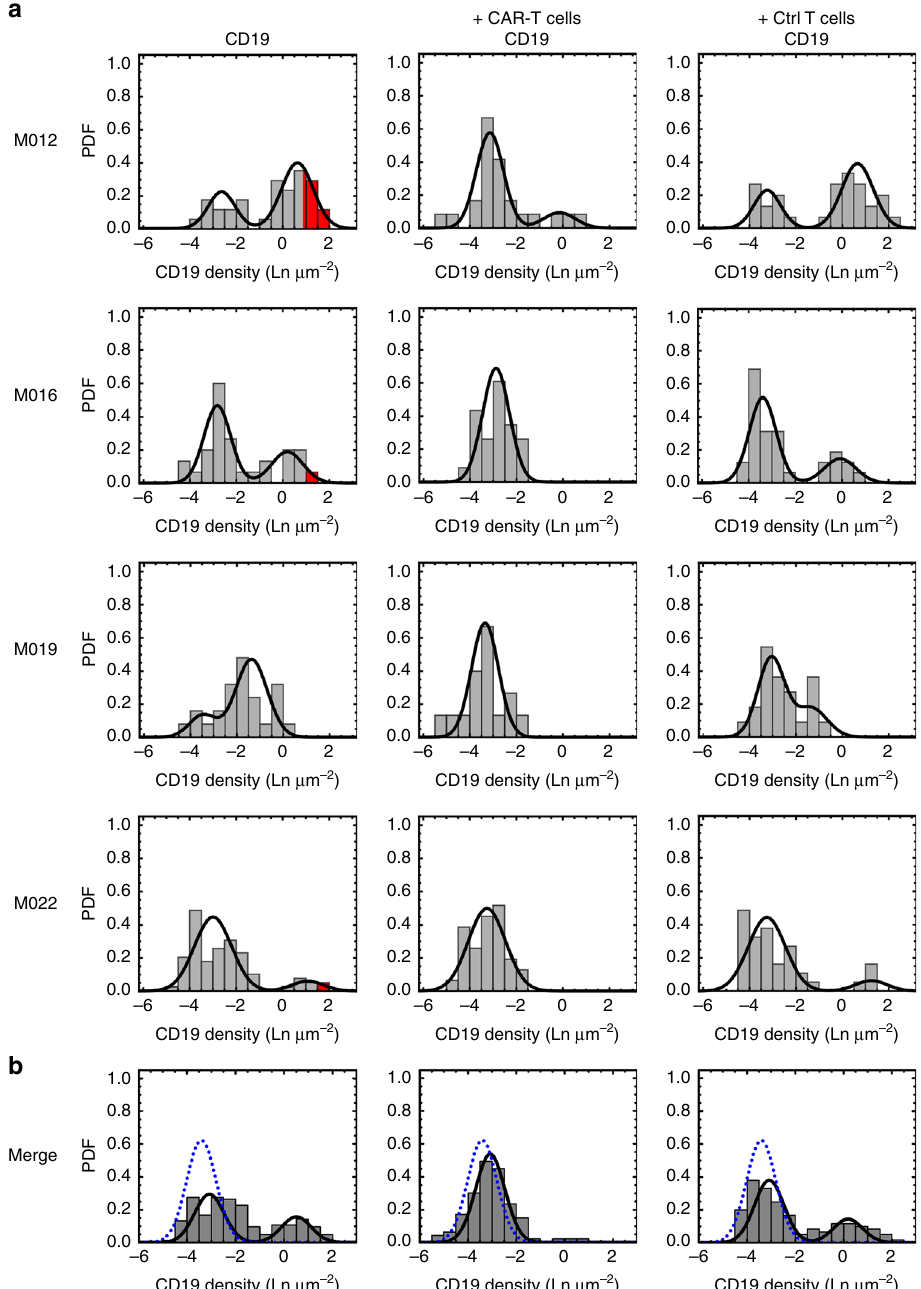
Fig. 3 Elimination of CD19-positive myeloma cells by CD19 CAR-T. a Expression pro fi les for CD19 on myeloma cells from patient M012, M016, M019, M022 and a merge of these four patients ( b ) generated by d STORM. Distribution plots showing the relative CD19 density obtained after staining with anti- CD19 antibody on myeloma cells before and after treatment with CD19 CAR-T or untransduced control T cells. Densities are provided as logarithmic numbers (natural logarithm, Ln) of molecules per µ m 2 . Probability density functions (PDFs) were fi tted with a one or two-component log-normal function that was dependent on the fi t-accuracy calculated with an Anderson-Darling test (rejected at a p -value < 0.05). For each patient, the percentage of myeloma cells that had been determined to be CD19-positive by fl ow cytometry is provided for comparison (red segments). For better visualization, the function of the isotype control is included in the CD19 staining for the merge panels (dotted blue line). Data for all patients are shown in Table 1 and Supplementary Fig.